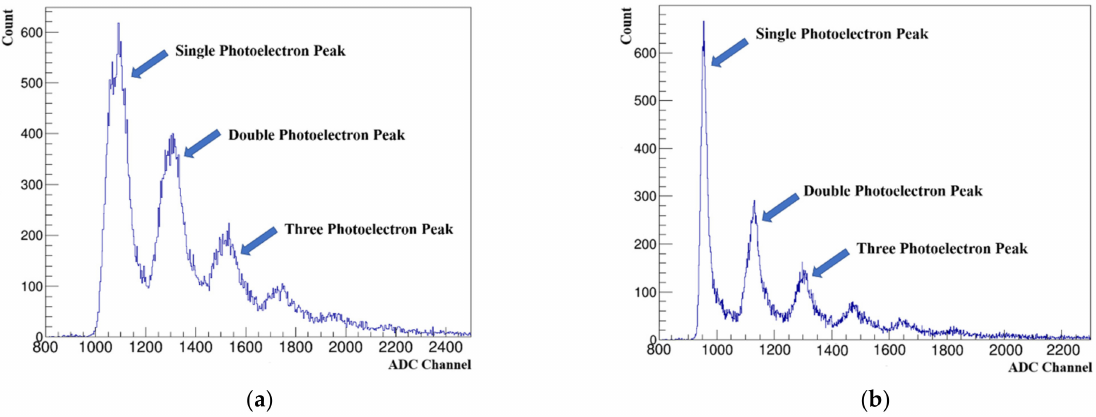
Figure 6. ( a ) Dark noise spectrum of SiPM at room temperature, V over = 2.5 V; ( b ) dark noise spectrum of SiPM at liquid nitrogen temperature, V over = 2.5